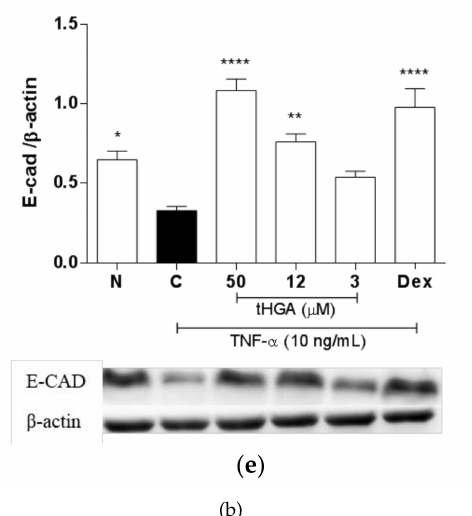
Figure 5. The effects of tHGA on the expression of apical junctional complex molecules in A549 cells following TNF- α induction. ( a , b ) The gene and protein expression of tight junctions, ZO-1 and ( c , d ) occludin. ( e ) The protein expression of adherens junction E-cadherin in A549 cells following TNF- α induction. A549 cells were stimulated with TNF- α (10 ng/mL) and treated with increasing concentrations of tHGA and positive control for 24 h. RNA or protein was extracted and analyzed using One Step Reverse Transcriptase PCR or Western blot analysis, respectively, as described in Methods. All values are expressed as mean ± SEM of at least three independent experiments, where * p ≤ 0.05, ** p ≤ 0.01, *** p ≤ 0.001 and **** p ≤ 0.0001 versus TNF- α -induced cells, according